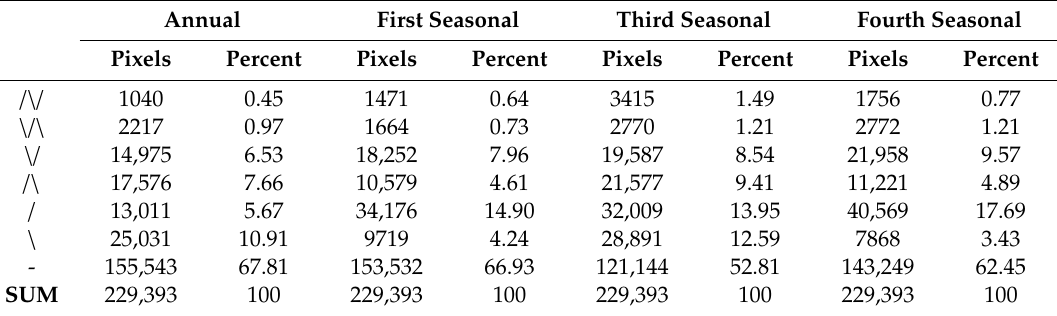
Table 2. Pixel numbers of di ff erent trend at annual and seasonal scales and the percent account of all valid land